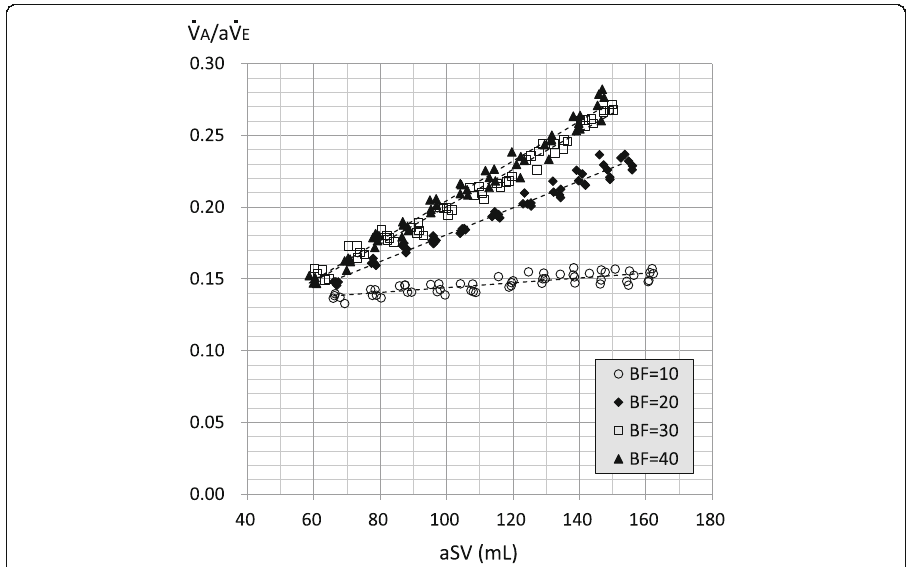
Fig. 5 Relationship between actual stroke volume (aSV) and ventilation efficiency ( _ VA/a _ VE). Legend: Markers indicate individual data of aSV and _ VA/a _ VE. Dotted lines are the first-order approximations. The coefficient of correlations ( R ) and P values are as follows: BF = 10: R = 0.824, P < 0.001; BF = 20: R = 0.989, P < 0.001; BF = 30: R = 0.990, P < 0.001; and BF = 40: R = 0.996, P <